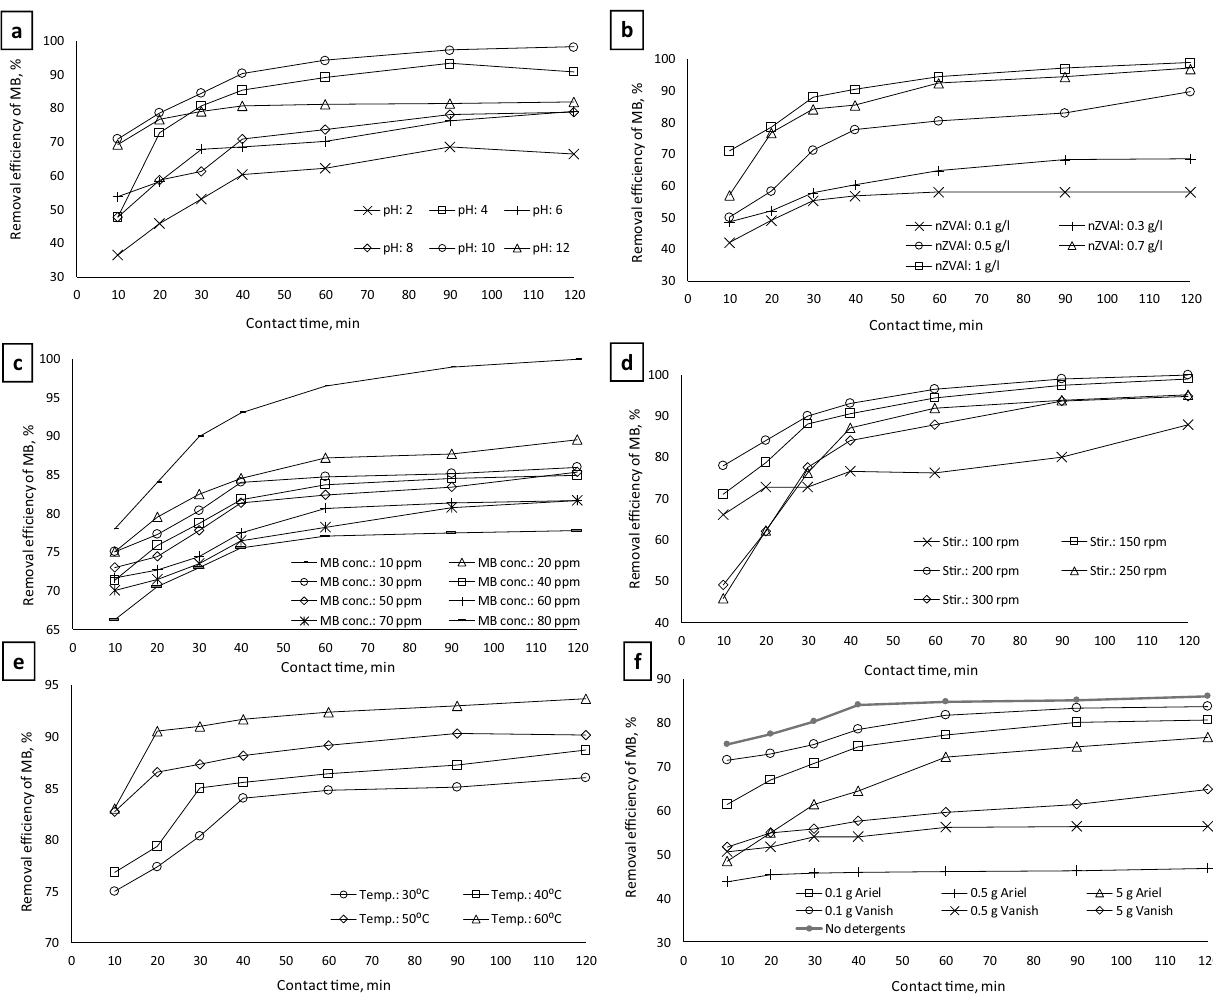
Fig. 4 Effects of operating parameters on the removal efficiency of MB by nZVAl a initial pH at C o = 10 mg/L, stirring rate 150 rpm, nZVAl dosage 0.5 g/L, and temperature 30 °C, b nZVAl dosage at pH 10, C o = 10 mg/L, stirring rate 150 rpm, and temperature 30 °C, c C o at pH 10, nZVAl dosage 1.0 g/L, stirring rate 200 rpm, and